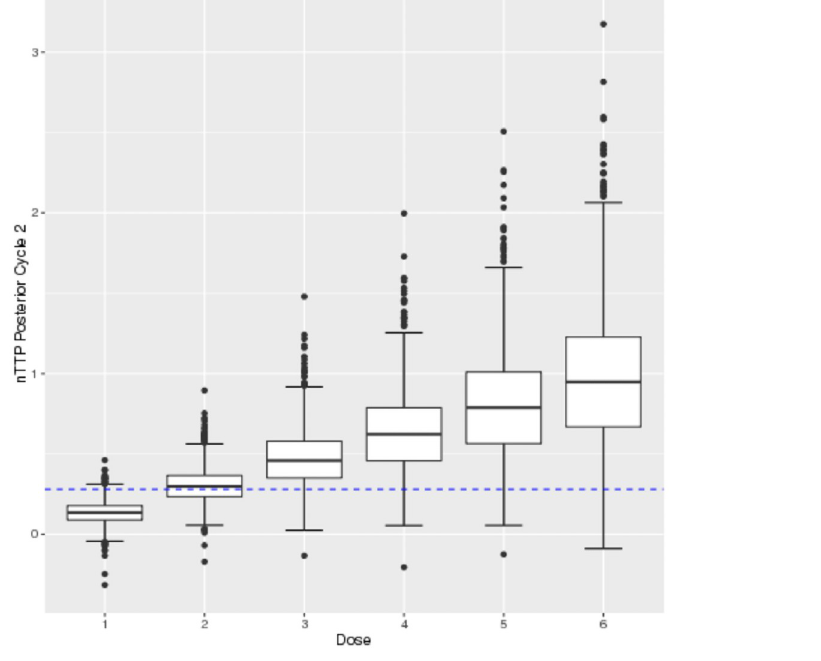
Fig 2. Cycle 2 posterior